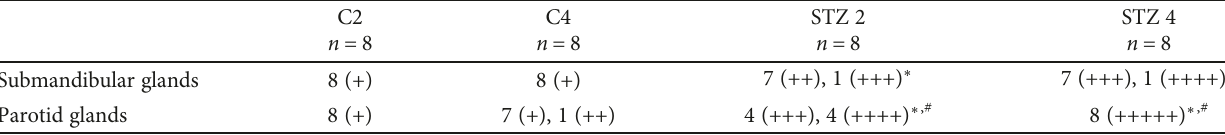
Table 3: The e ff ect of STZ-induced diabetes on histological observation in the salivary